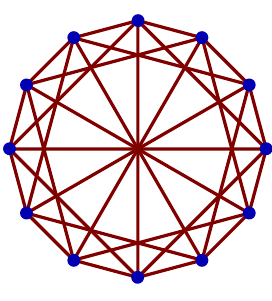
Figure 12 . Graph of (6.49), a representative from one of the T-equivalence classes associated with the dodecacode. The corresponding refined enumerator polynomial is given by (6.45). As a binary isodual code it is isospectral with h + . Via the twist construction it gives rise to a non-integer 24 isodual lattice isospectral with the odd Leech